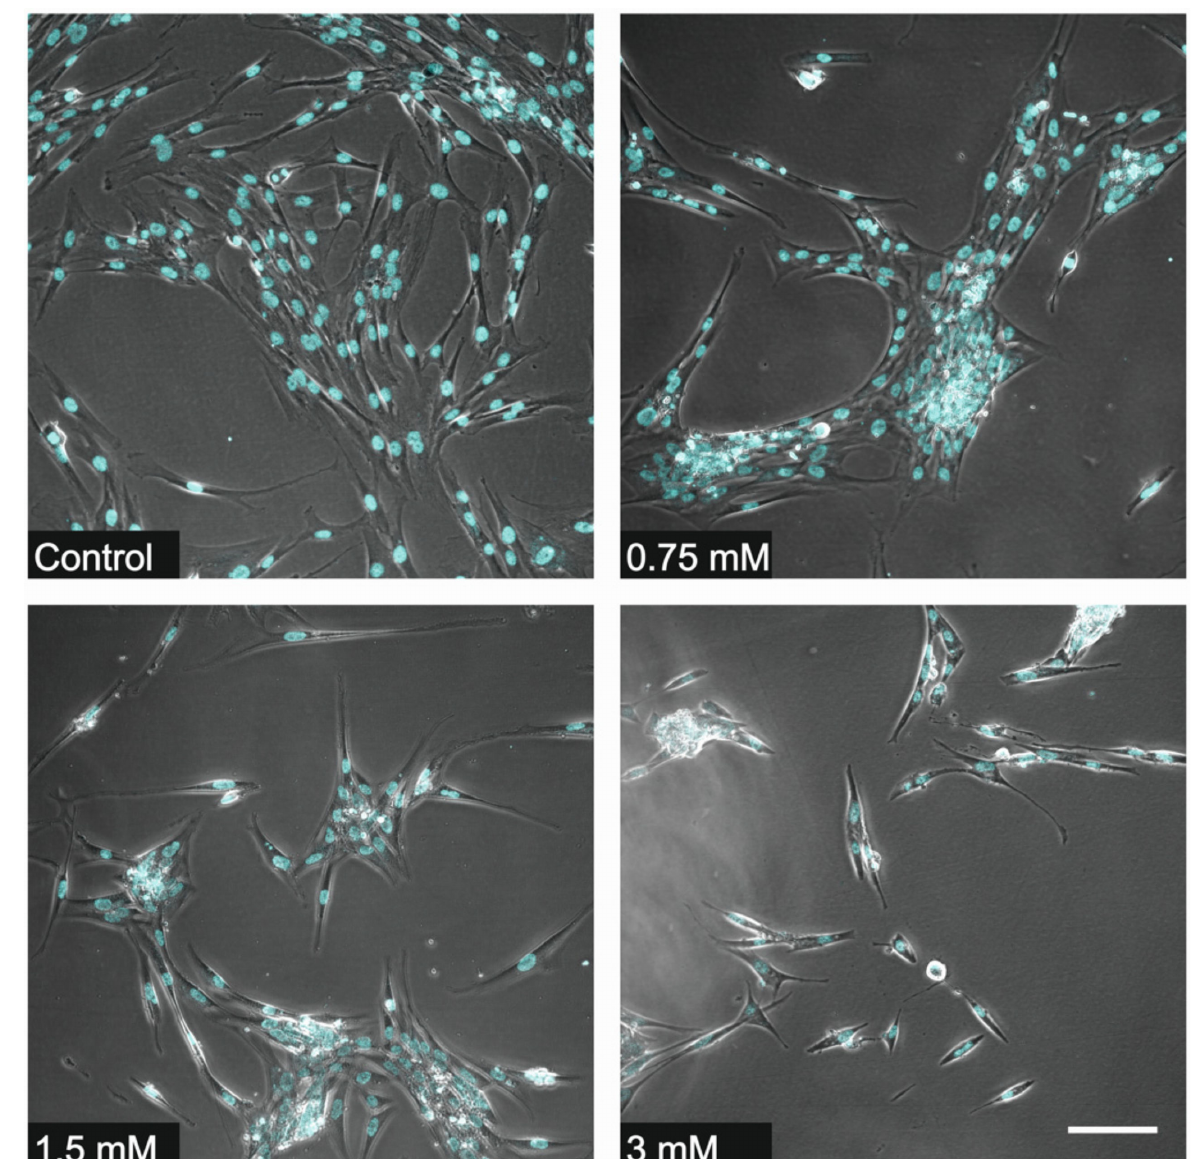
Figure 4. Illustrative microscope images showing the change in viable cell number over the course of the investigation (sample number: n = 2, 20X dry objective, scale bar represents 100 µ